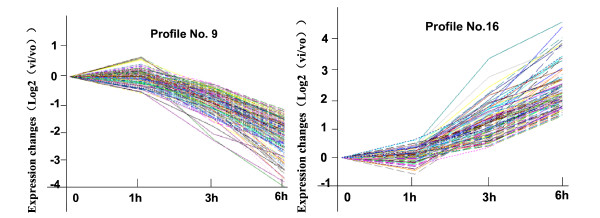
Gene expression of profile No.9 and No. 16 in the context of significant ConA-induced liver injury. The profile No.9 (A) contained 209 genes and they decreased in expression consistent with prolonged liver damage after injecting ConA. The profile No.16 (B) had 118 genes and they increased in expression consistent with prolonged liver damage after the injection. These processes may indicate that the assigned genes closely correlate with the results of regulatory gene expression, including activation and inhibition in the context of liver damage caused by ConA challenge. The horizontal axis represents time, and the vertical axis shows the time series of gene expression levels for the gene after Log normalized transformation.